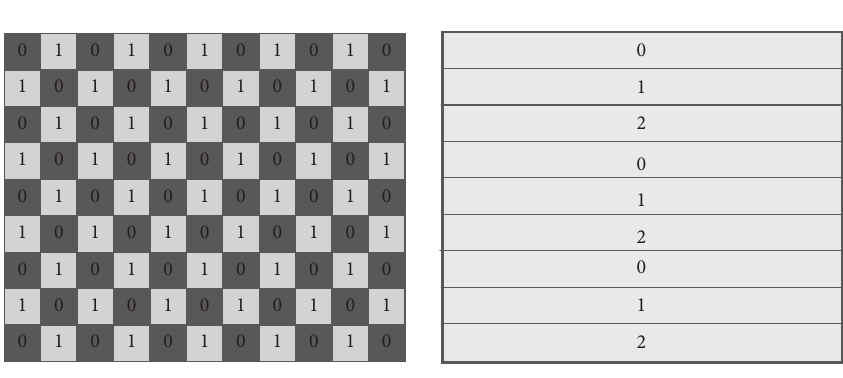
Figure 9: FMO mode.